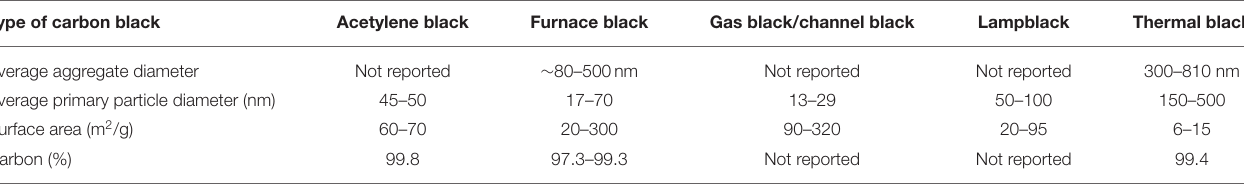
* Table abstracted from Table 89.3 of McCunney et al. “Carbon Black,” in Pattys Industrial Hygiene and Toxicology (2022, in press). Data are based on original material from M.-J. Wang, C. A. Gray, S. A. Reznek, K. Mahmud, and Y. Kutsovsky, Carbon black, in Kirk-Othmer Encyclopedia of Chemical Technology, 2003, and G. Locati, A. Fantuzzi, G. Consonni, I. Li Gotti,